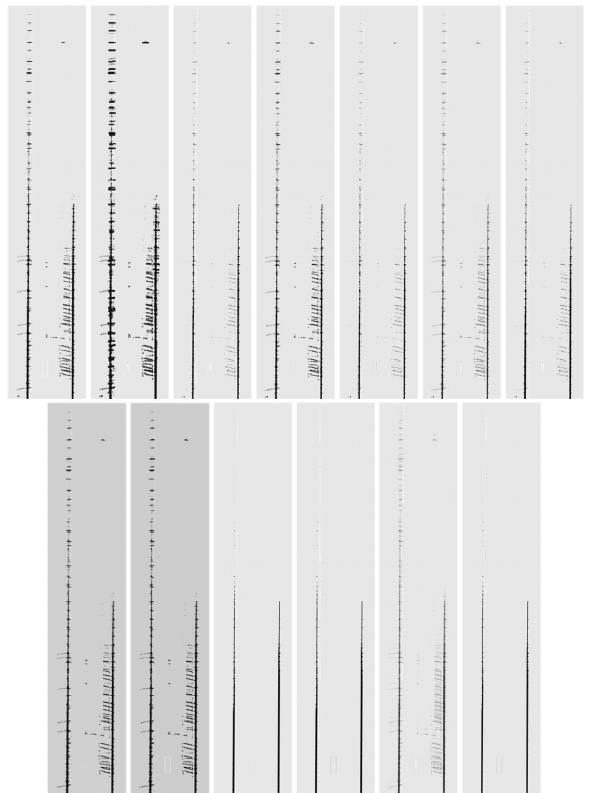
Figure 13. Snapshots of resultant occupancy grid for fusion variants in the first row: LL-B, LL-DS, HL-B, HL-M, HL-LI, HL-L, HL-I; in the second row: HL-De, HL-S, FHL-B, FHL-LI, FHL-L, FHL-I for Scenario